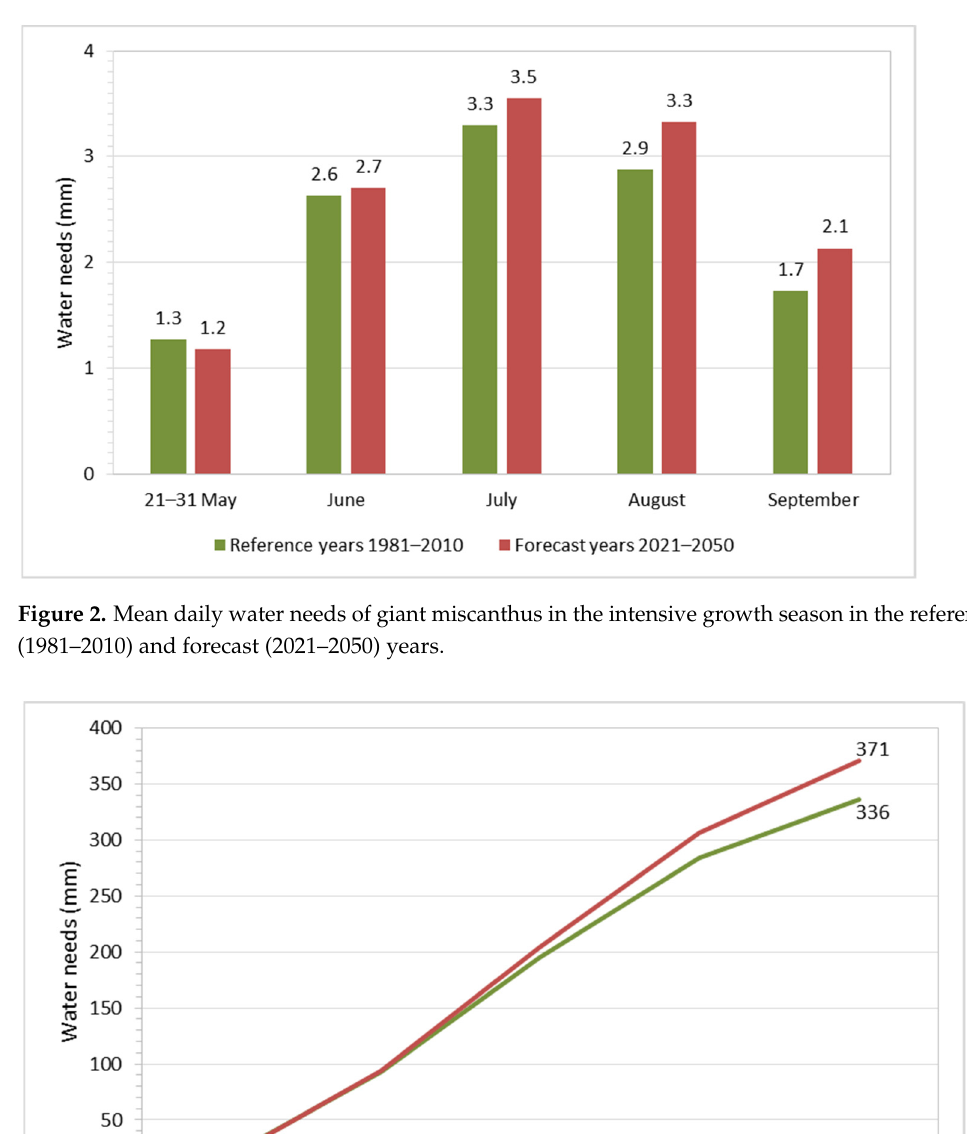
Figure 2. Mean daily water needs of giant miscanthus in the intensive growth season in the reference